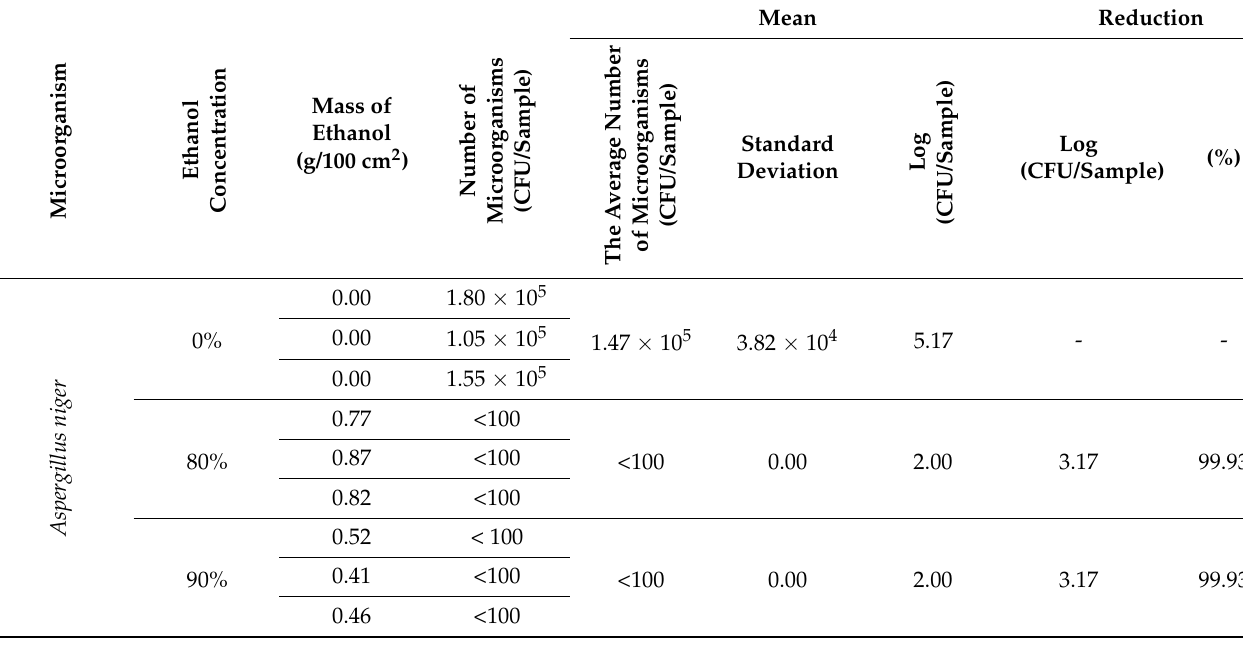
Table 3. Evaluation of the long-term effectiveness of 80% ethanol applied for 10 s and 90% ethanol applied for 9 s on the model fabric and samples stored for 22 h in a closed